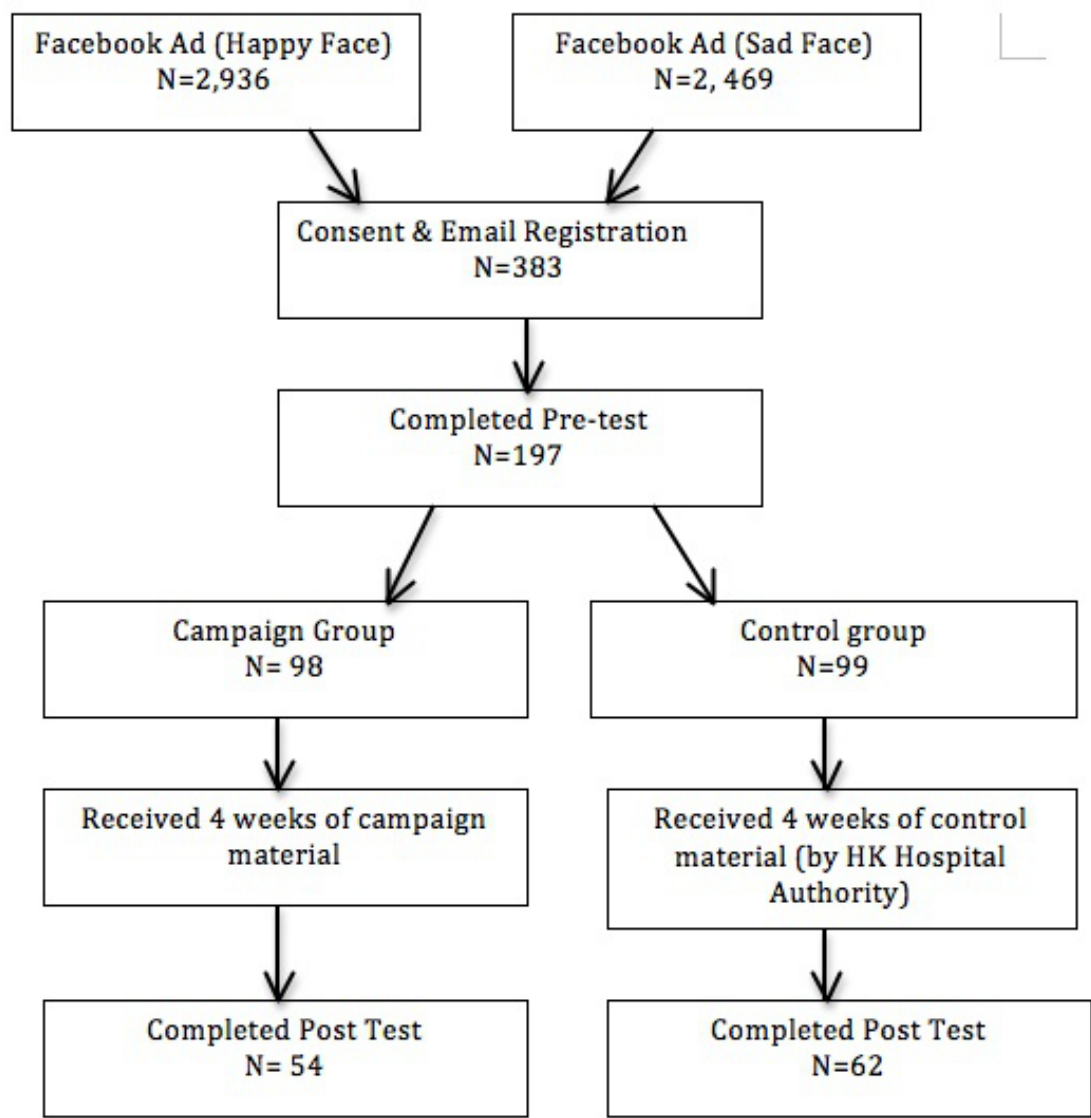
Figure 3. Flow chart of the